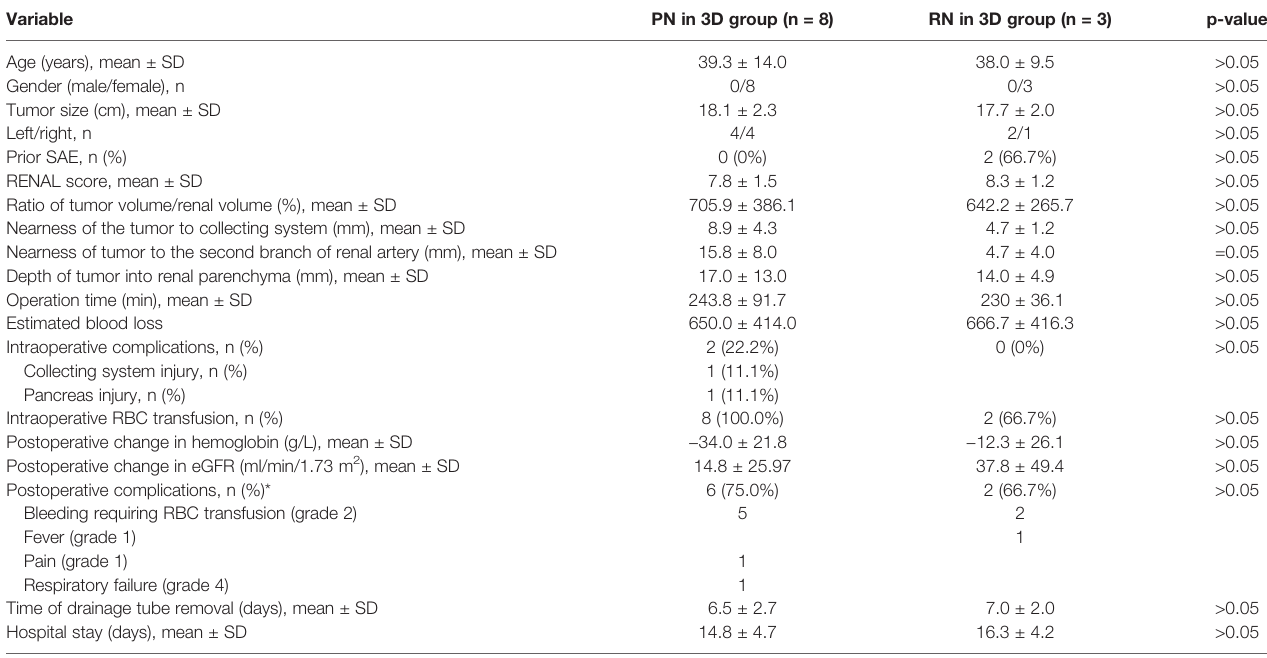
TABLE 5 | Subgroup analysis of perioperative parameters and clinical outcomes in 3D group.